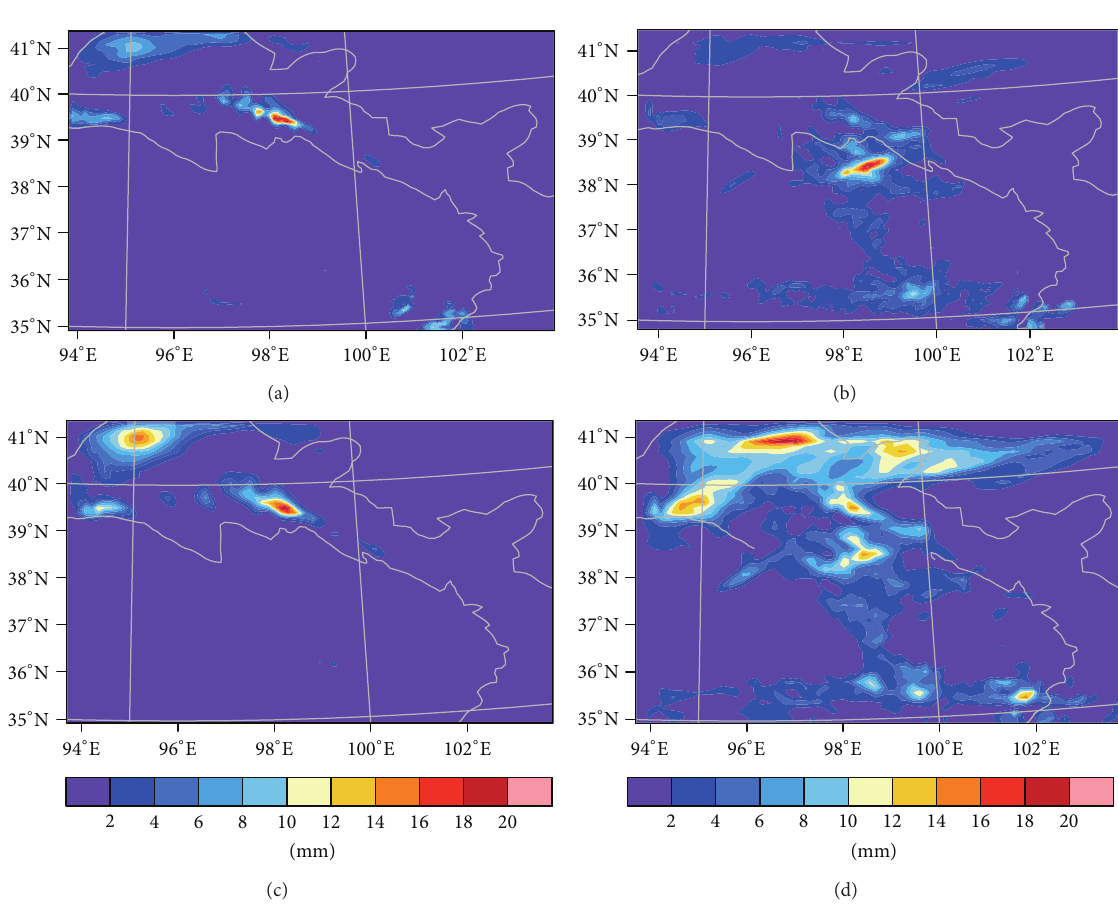
Figure 5: The forecast precipitation for Event A from the different numerical experiments: (a) CTRL; (b) DA-SAT; (c) DA-OBS; (d) DA-